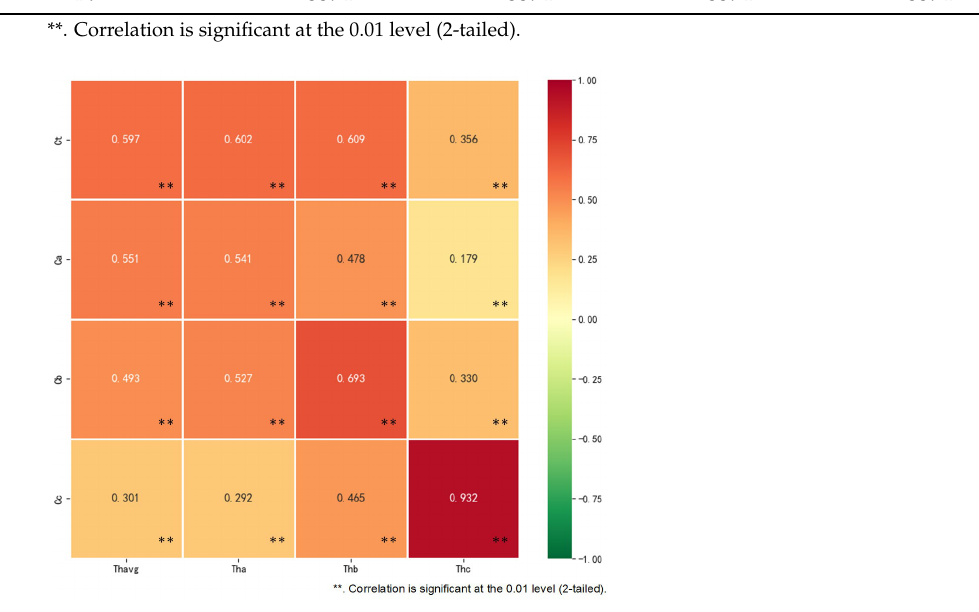
Figure 8. The correlation coefficient between sea ice concentration and sea ice thickness.